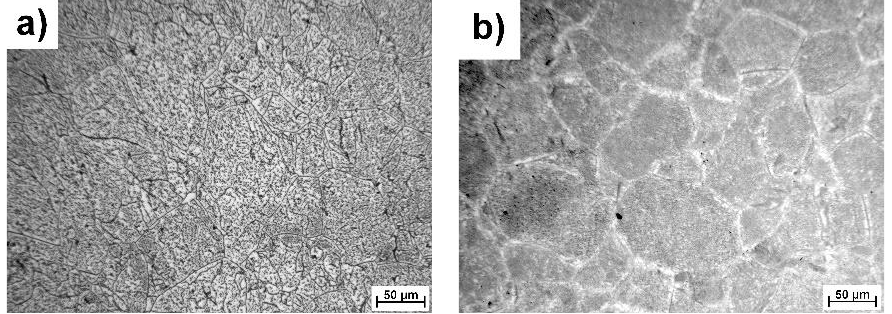
Figure 4. Microstructure of Ti-25Nb-4Ta-8Sn alloy prepared by SPS ( a ) and after heat treatment ( b ) (optical microscope).